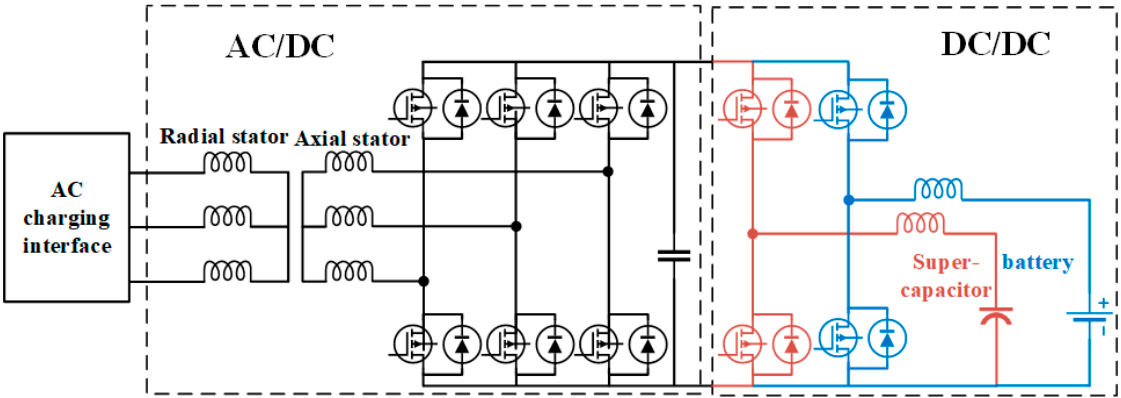
Figure 3. Diagram of charging mode.